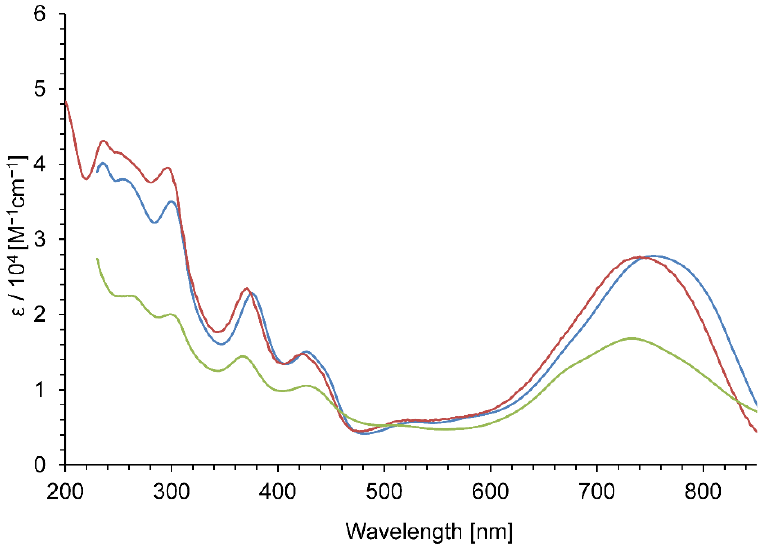
Figure 5. UV–Vis spectra of 3a + · PF 6 − in CH 2 Cl 2 (blue line), in MeCN (red line), and in 10% CH 2 Cl 2 /hexane (light green line).